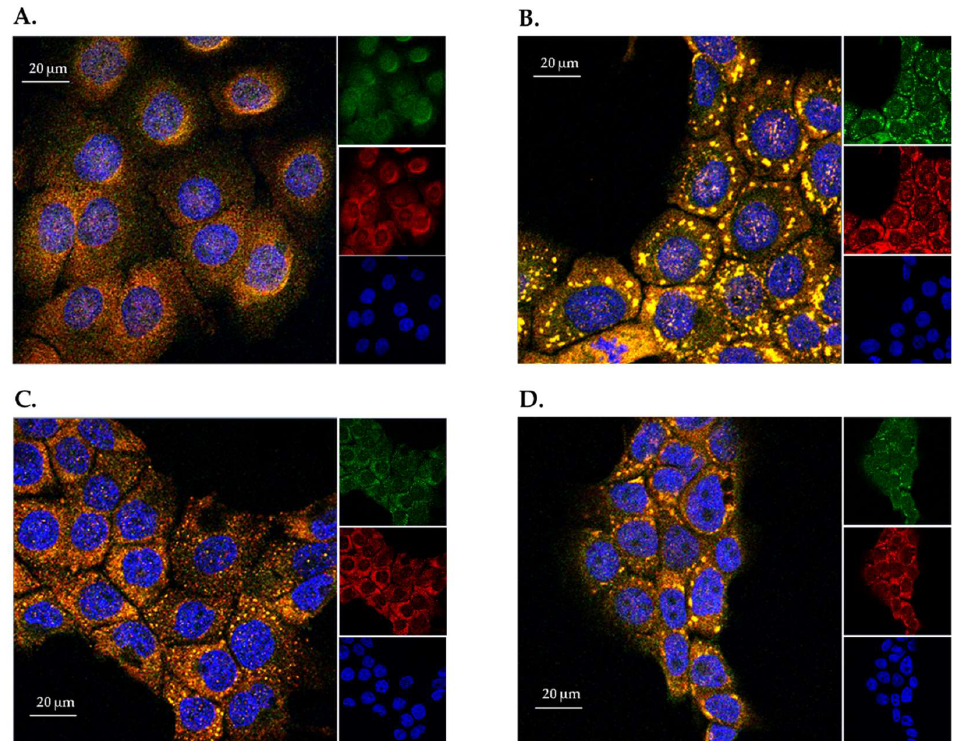
Figure 2 . Immunofluorescence analyses of ANG sub-cellular localization under physiological and stresses conditions. ( A ) HaCaT cells cultured in physiological conditions; ( B ) HaCaT cells treated with SA for 1 h at 37 °C; ( C ) HaCaT cells treated with 1 mM of hydrogen peroxide for 2 h at 37 °C; ( D ) HaCaT cells subjected to thermal stress at 45 °C for 1 h. Cells were co-stained with PABP (red), ANG (green) and blue staining (DAPI) for nuclei. Yellow spots indicate the co-localization between ANG and PABP at the level of SGs.